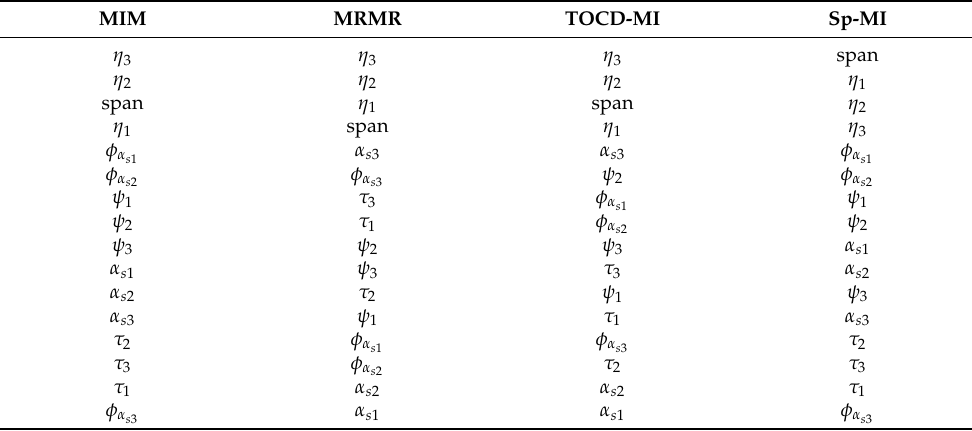
Table 2. Parameter ranking result of Oberpfaffenhofen image based on different methods of mu- tual information.